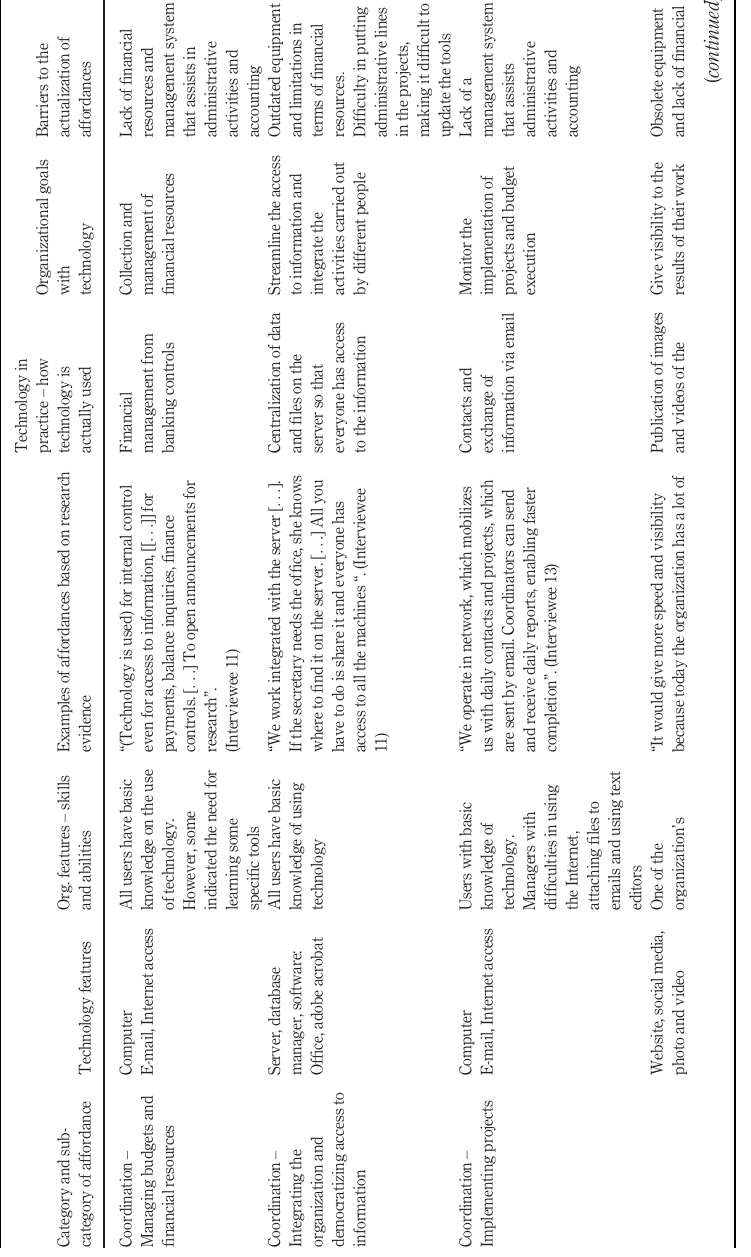
Table AI. Affordances of the culture case (example of an analytical table used for each